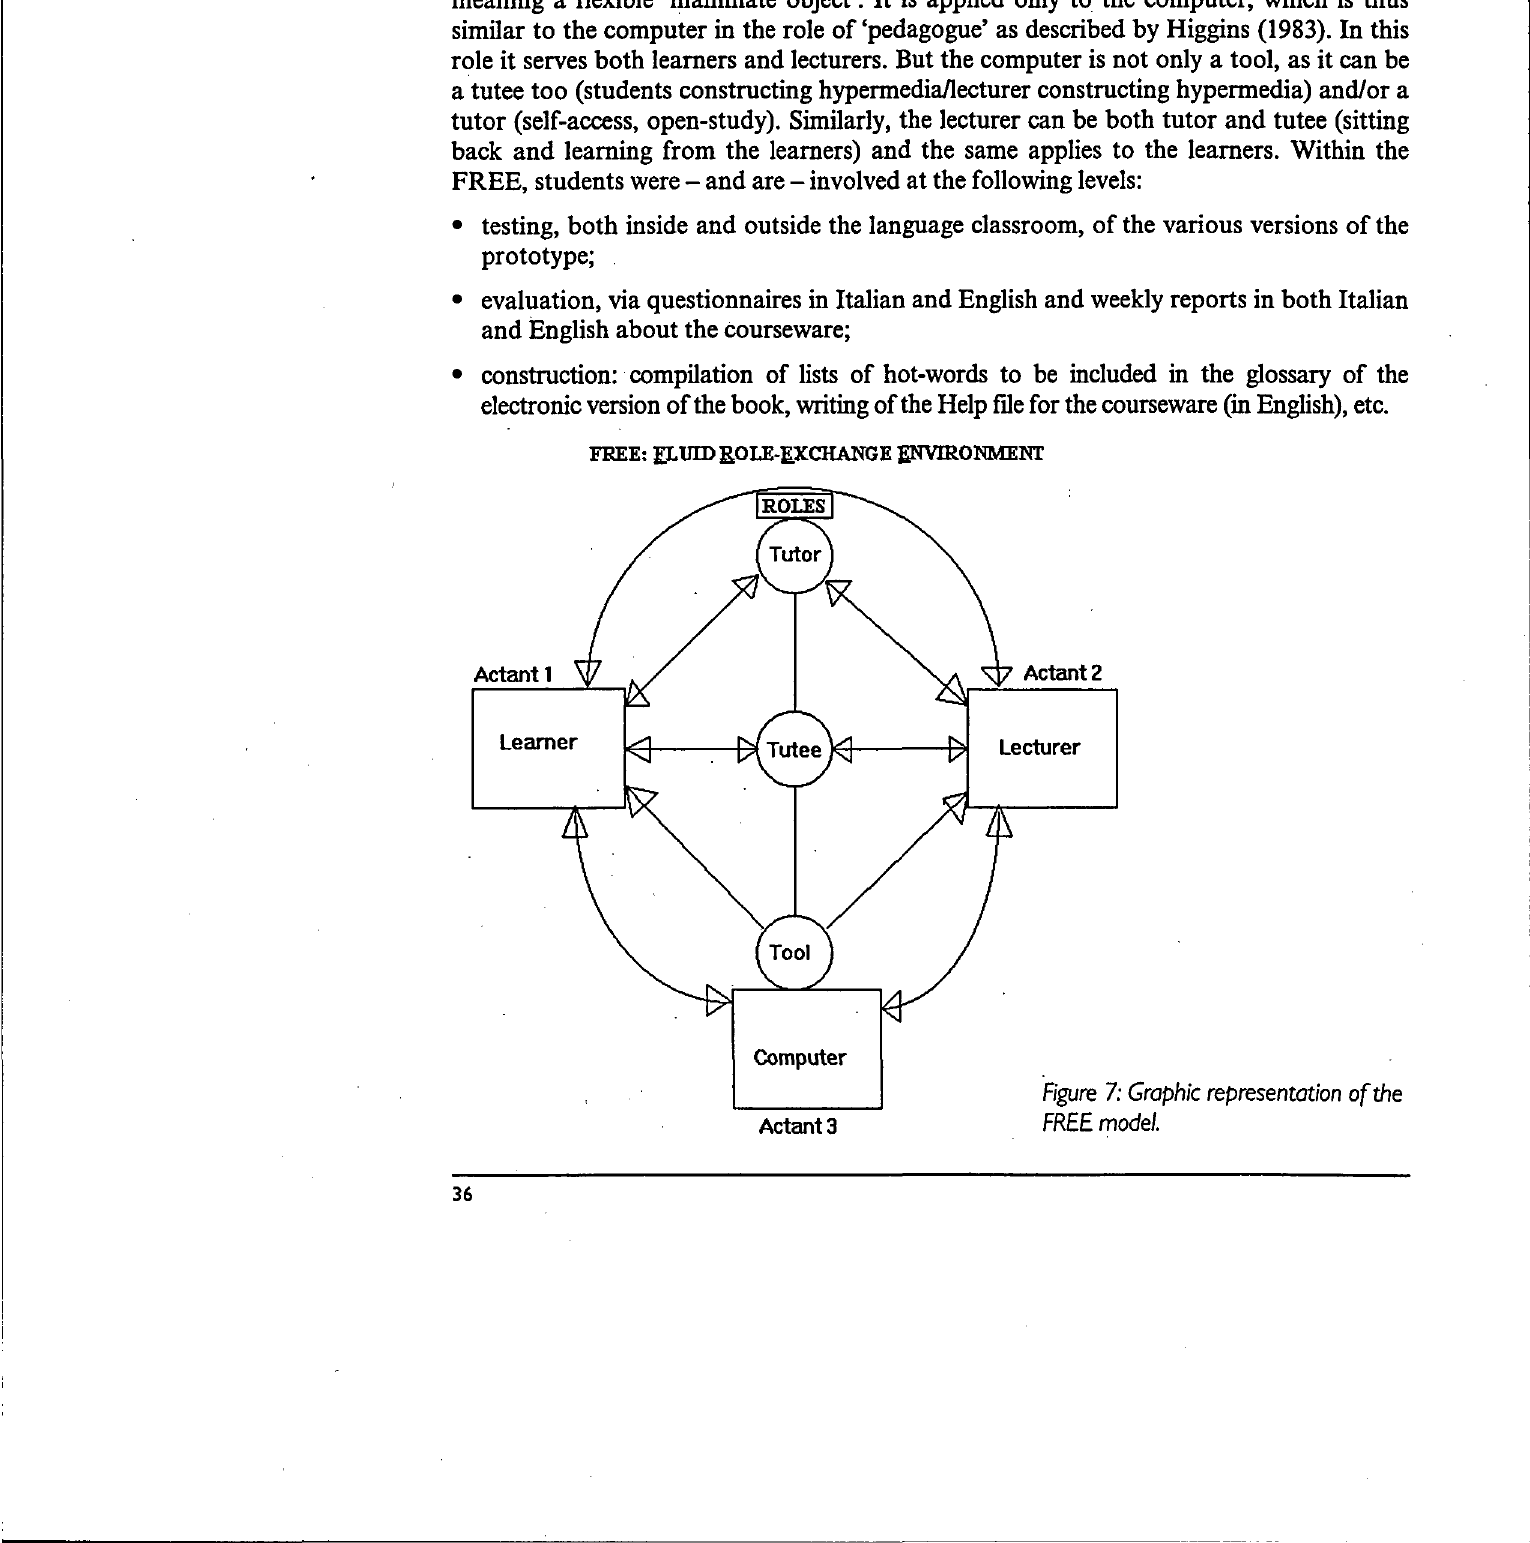
Figure 7: Graphic representation of the FREE